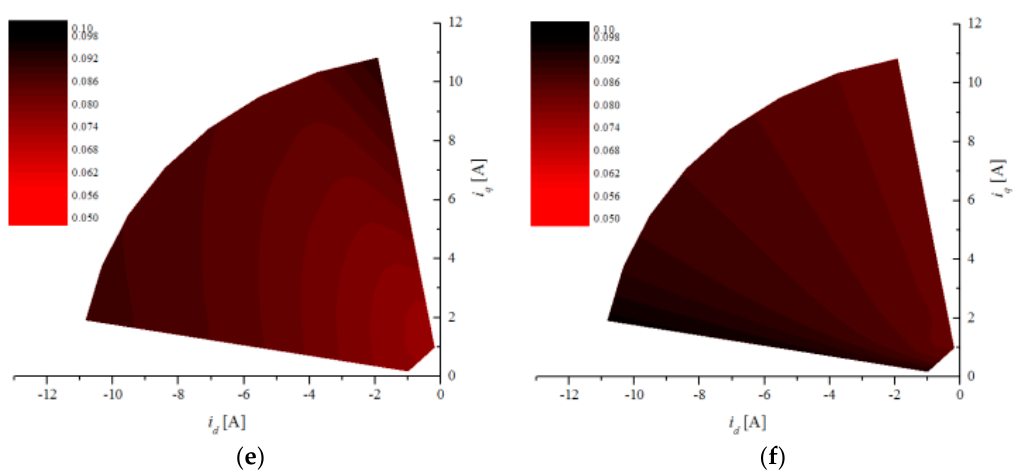
Figure 9. d - and q -axis inductance maps: ( a ) L d at − 40 °C; ( b ) L q at − 40 °C; ( c ) L d at 20 °C; ( d ) L q at 20 °C; ( e ) L d at 80 °C; ( f ) L q at 80 °C.